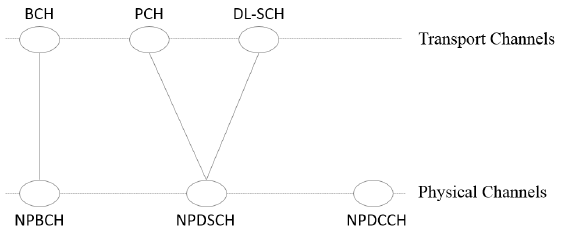
Figure 18. NB-IoT operation